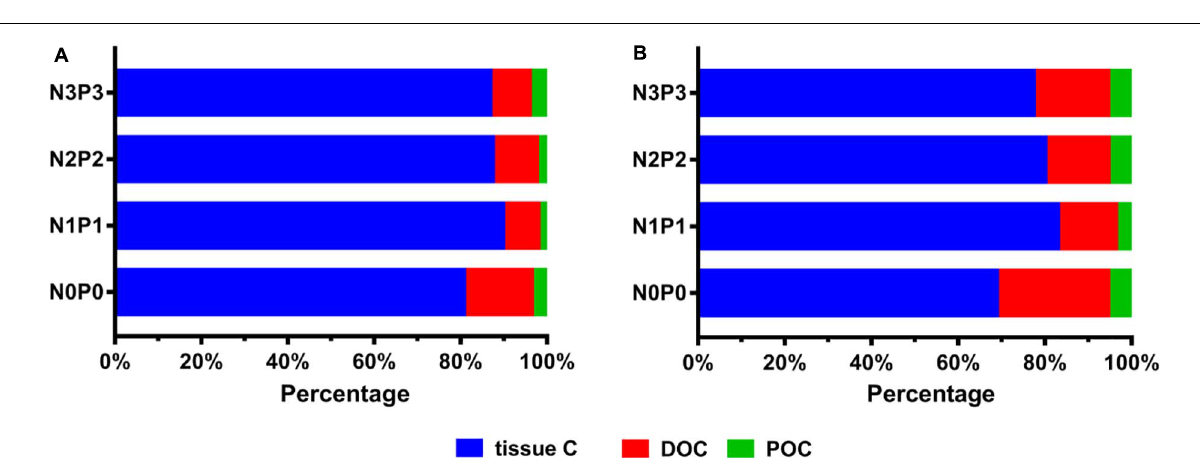
strain Z-61 under the lowest nutrient condition N0P0 (Xu et al., 2020). This is consistent with the present study, which found that, under N0P0, the N content of Z-26 was 62% higher